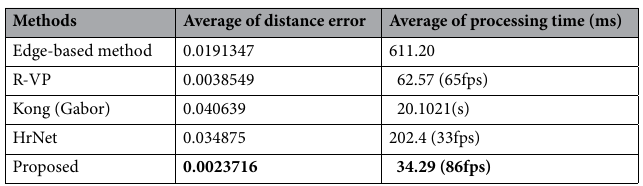
Table 2. performance comparison in terms of average distance and processing time between ground truths for various methods. Significant values are in bold.